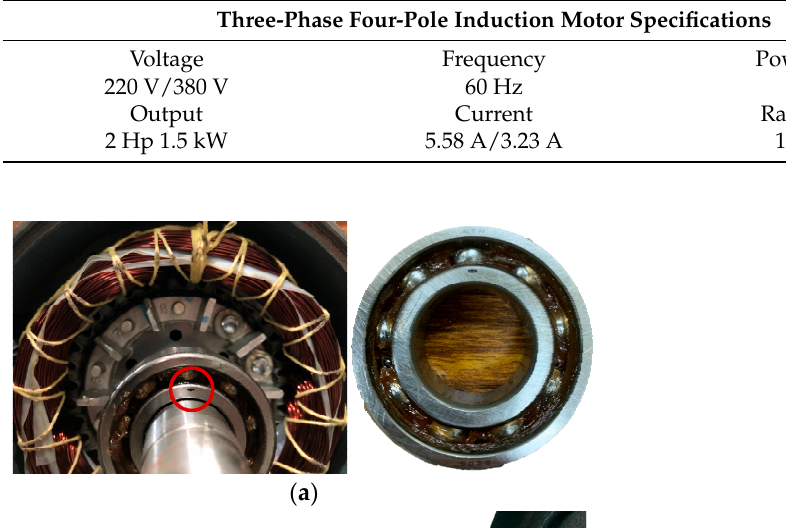
Table 4. AC induction motor specifications.